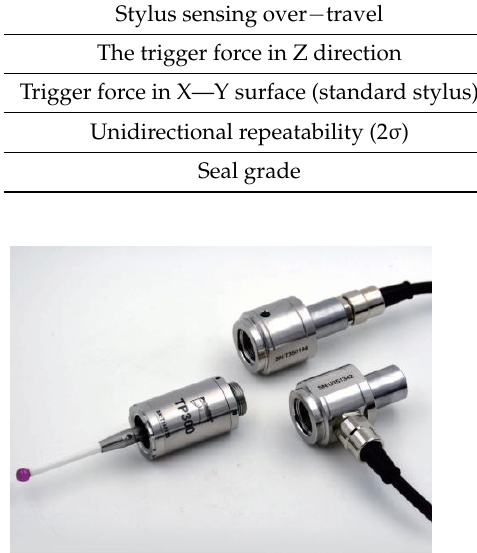
Figure 3. PIONEER TP300 series of cable probe.